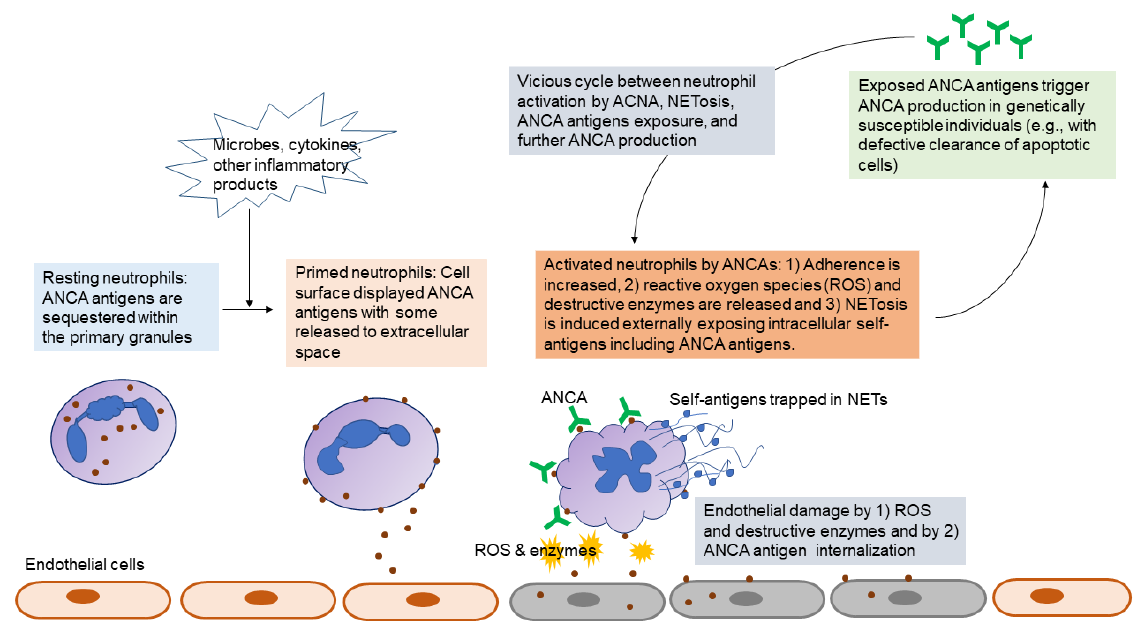
Figure 1. Pathogenic roles of antineutrophil cytoplasmic antibodies (ANCAs).